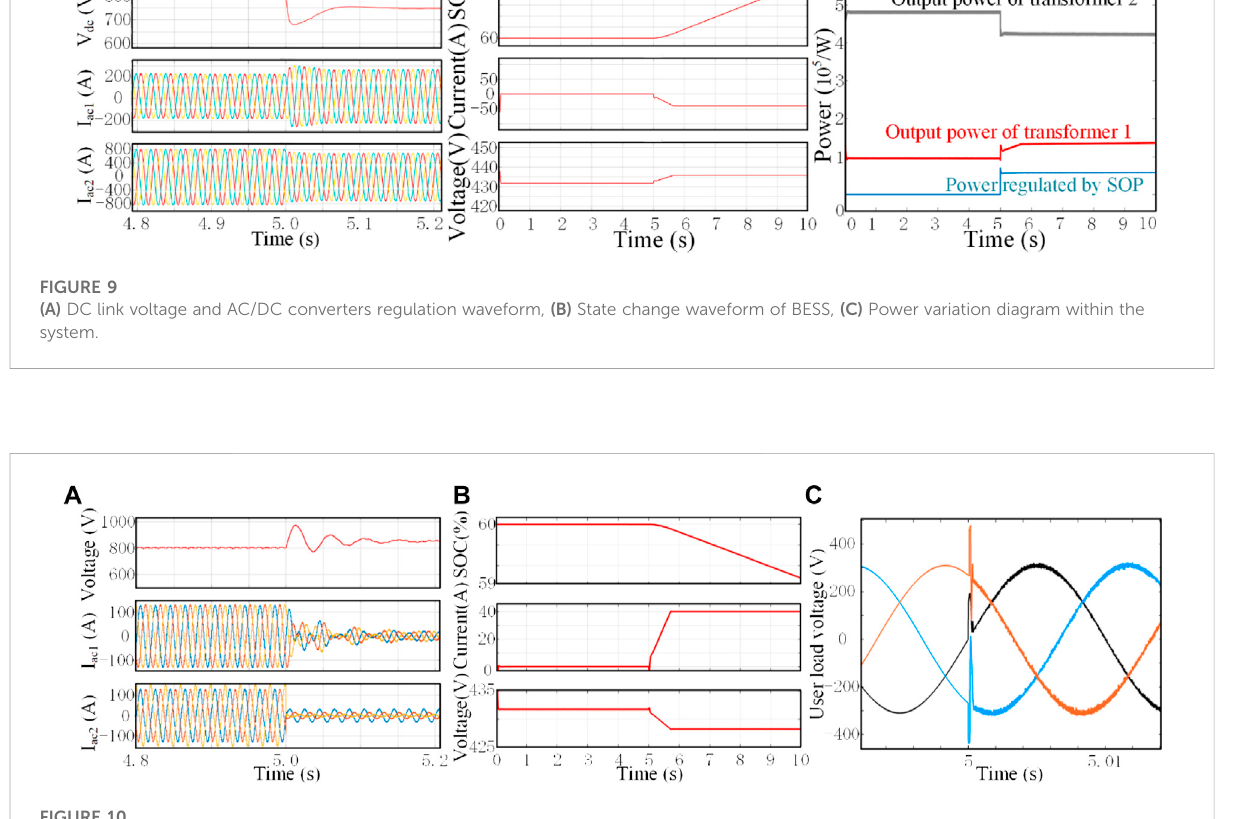
FIGURE 10 (A) DC link voltage and AC/DC converters regulation waveform, (B) State change waveform of BESS, (C) The voltage waveform of the user load on the fault